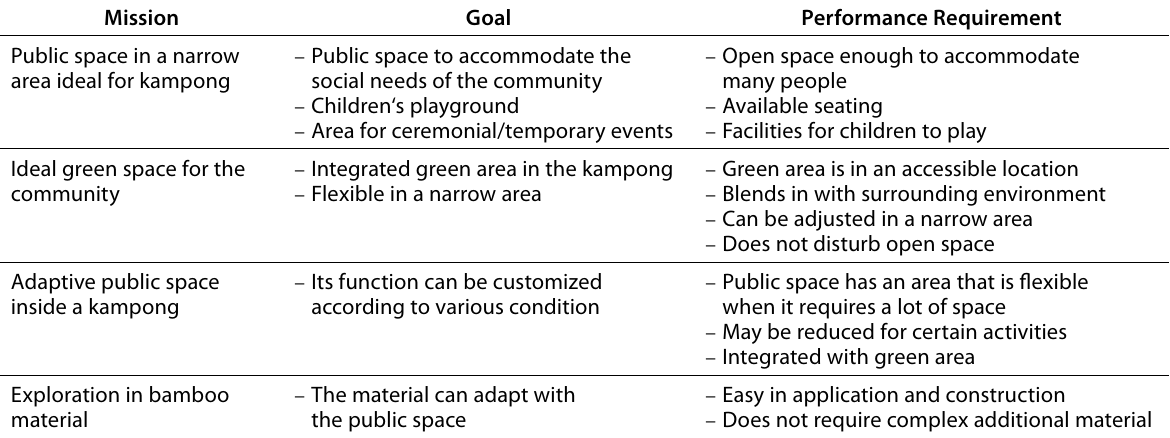
Table. Design criteria for a public space in Kampong